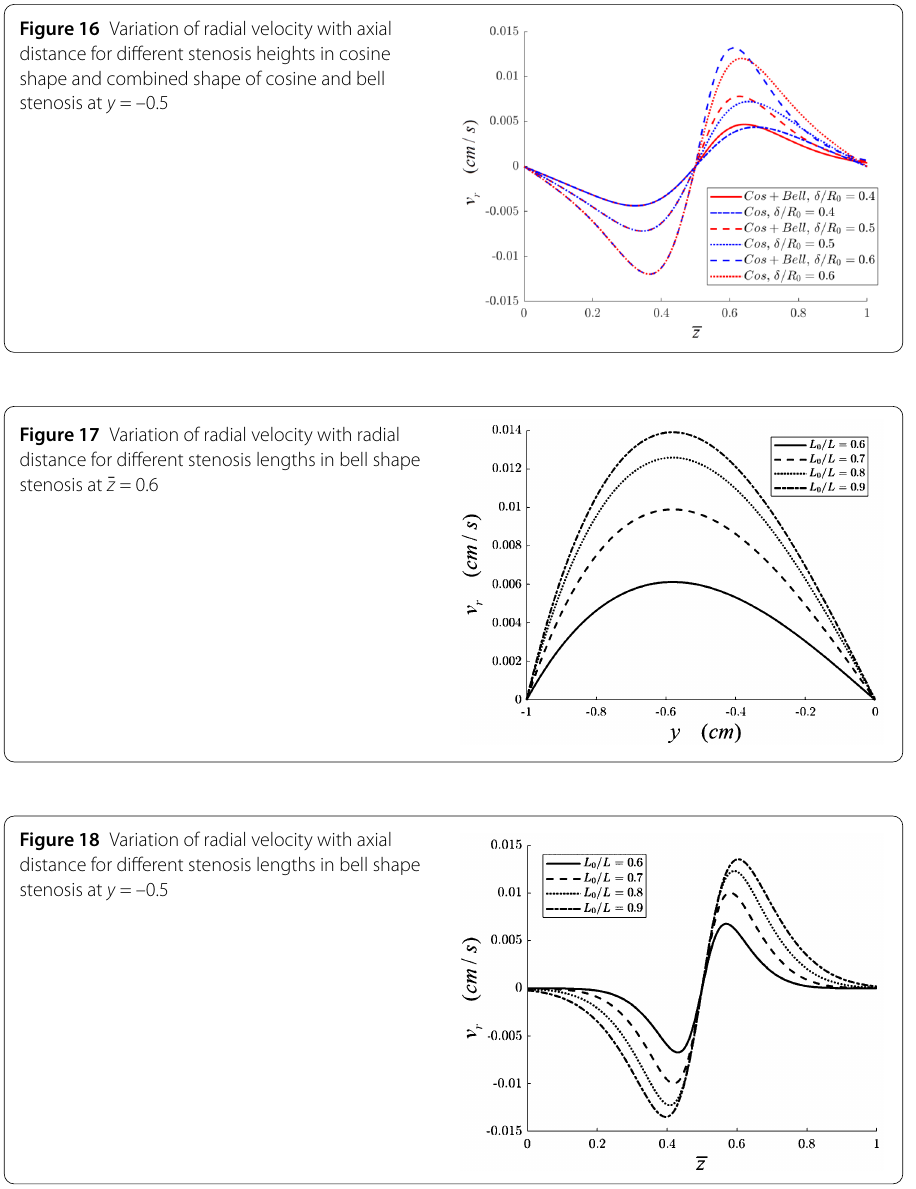
Figure 16 Variation of radial velocity with axial distance for different stenosis heights in cosine shape and combined shape of cosine and bell stenosis at y = –0.5